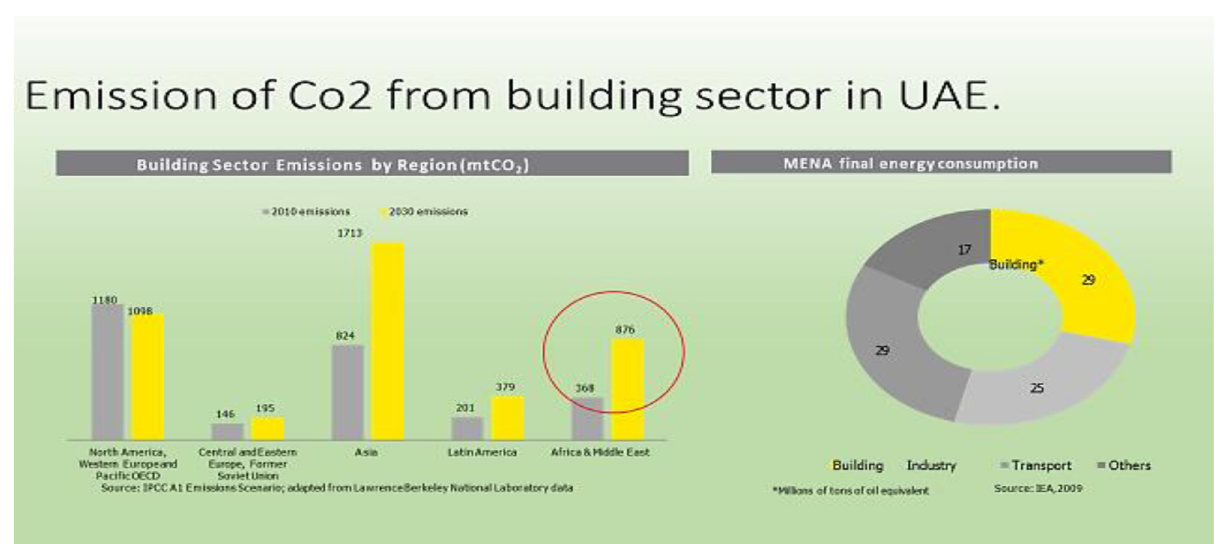
Fig. 13. CO 2 emission from building sector in